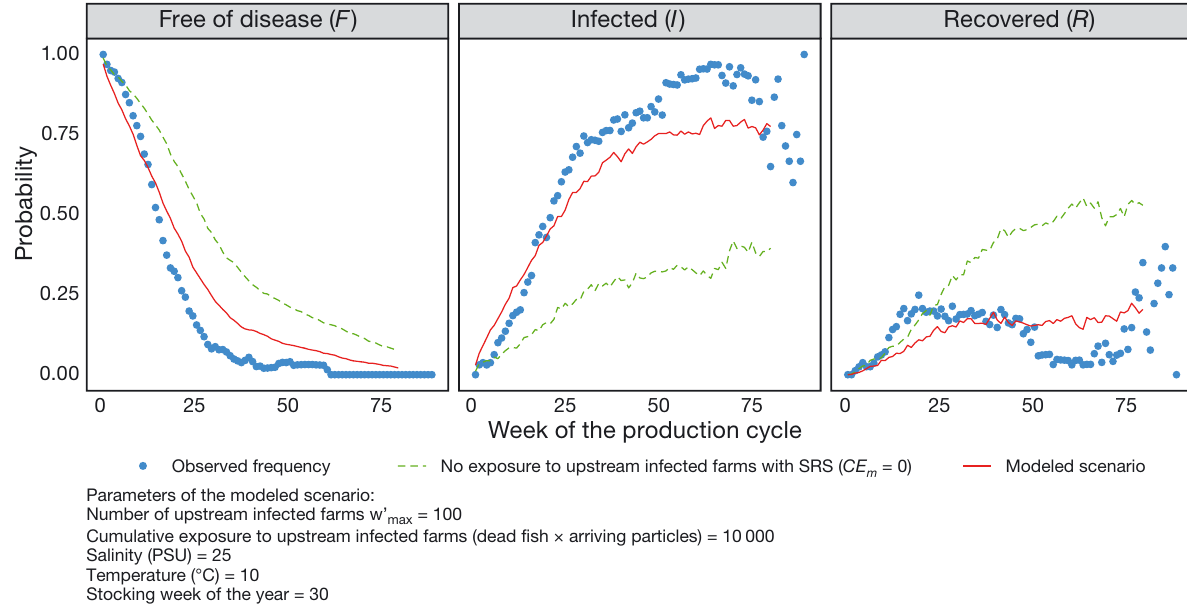
Cumulative exposure to upstream infected farms (dead fish × arriving particles) = 10000 Salinity (PSU) = 25 Temperature (°C) = 10 Stocking week of the year = 30 Fig. 8. Piscirickettsiosis dynamics as a function of the week of the salmon farming cycle, showing predicted (lines) and ob- served (dots) exposure scenarios. In both cases, temperature, salinity, and stocking week of the farm were assumed